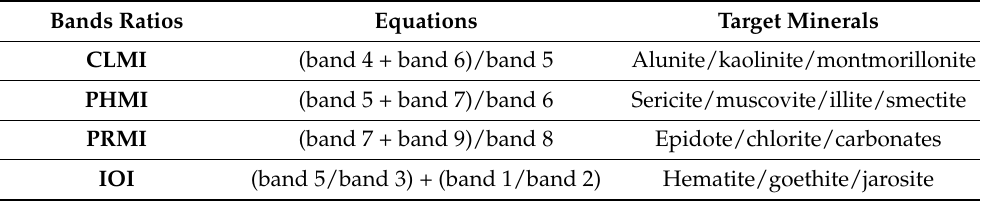
Table 3. Band ratios used in this analysis for mapping weathering zones in the study area.